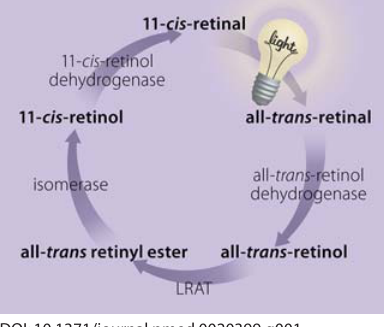
Figure 1. The Visual Cycle (Illustration: Giovanni Maki, adapted from